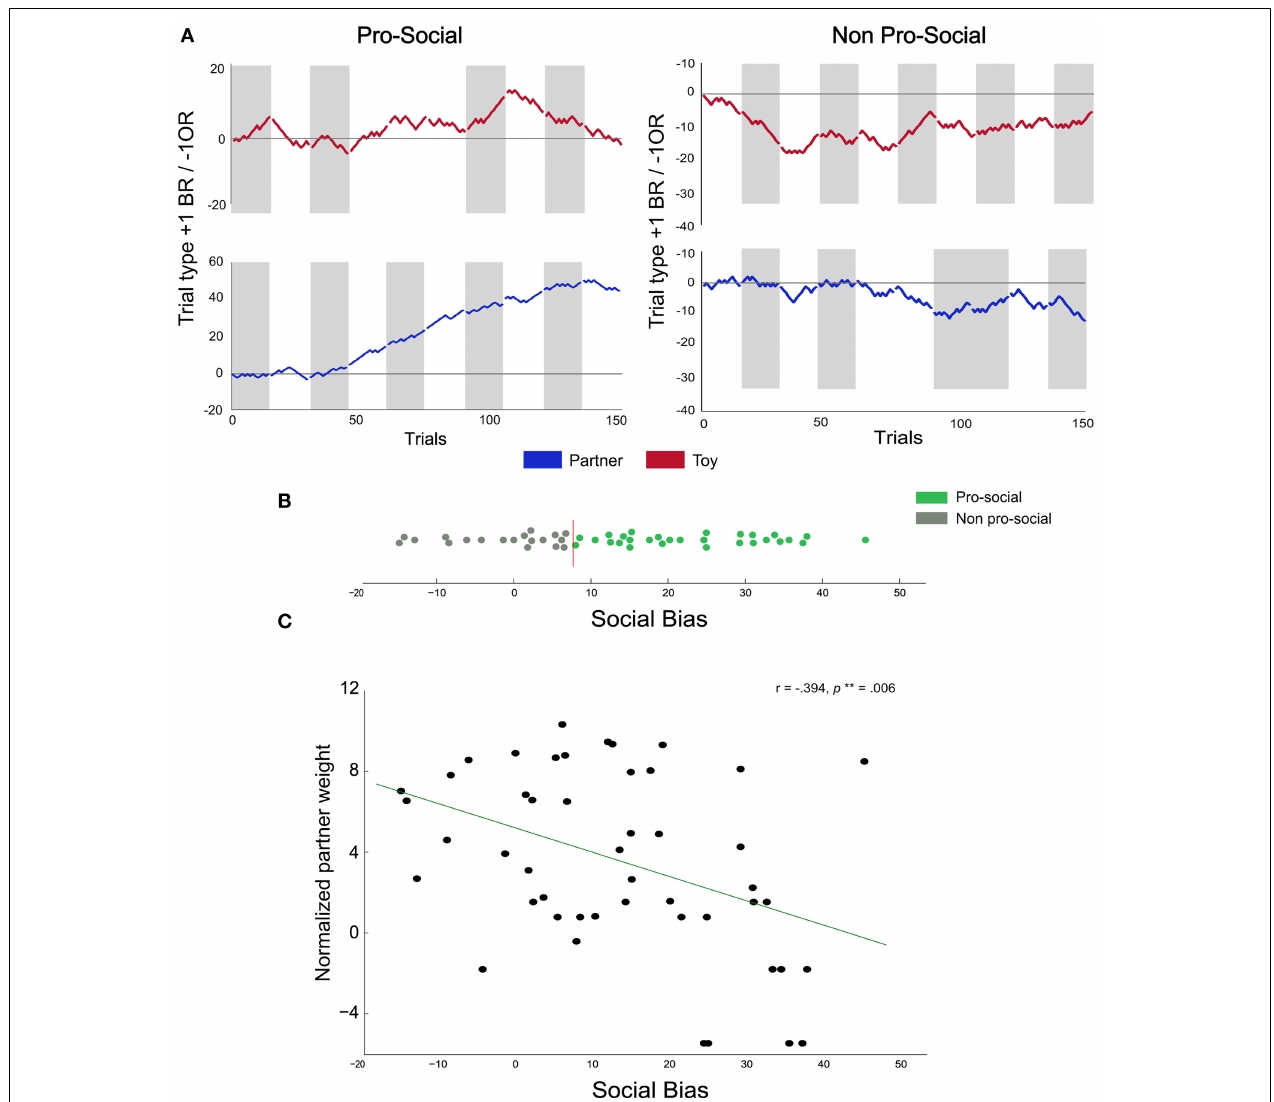
FIGURE 3 | Individual differences in pro-social behavior. (A) Cumulative choice plots illustrate individual differences in pro-social behavior: for each trial, the running pro-social tally is incremented by + 1 for each BR choice, and decremented by − 1 for each OR choice. Thus, a monotonous upward slope indicates consistent BR choices across trials and sessions, neutral slopes indicate indifference, and negative slopes indicate consistent OR choices. Gray areas represent sessions where the BR compartment was on the left side. The two left panels show the cumulative choice plots of a rat classified as pro-social (performance in